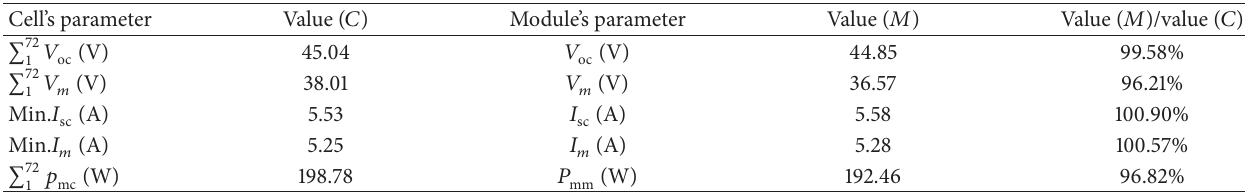
Table 3: Solar cell’s parameters and solar module’s parameters after busing.